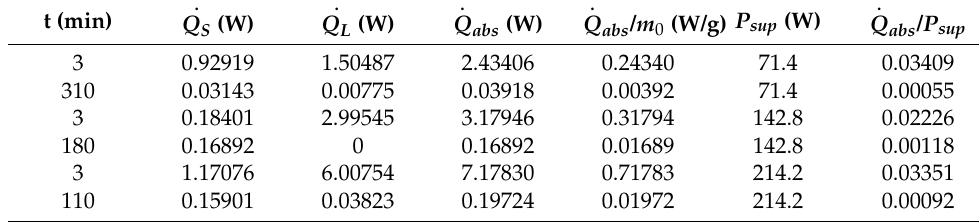
Table 5. Thermal energy data obtained in the